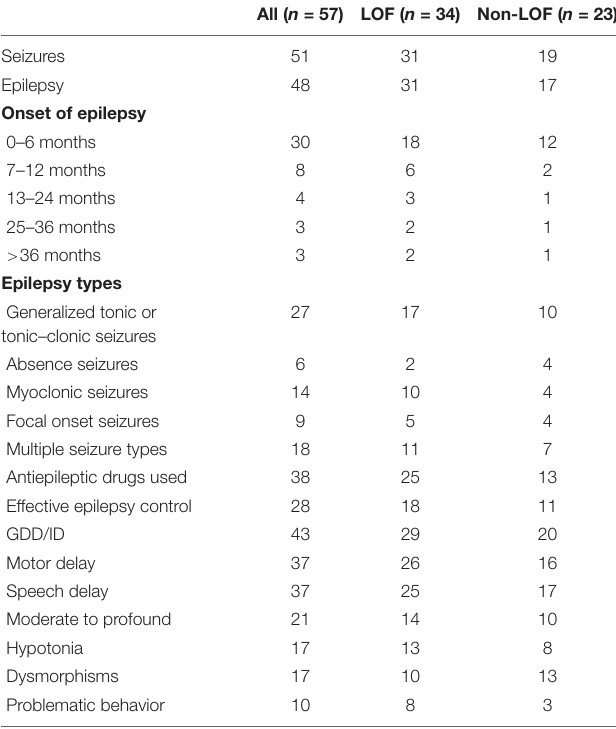
TABLE 2 | Phenotypes of CSNK2B clinical and epilepsy characteristics ( n =